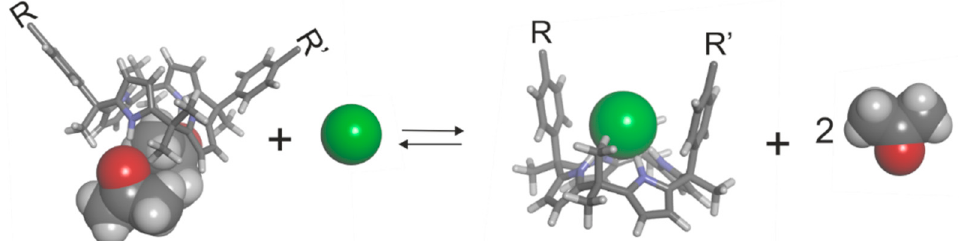
Figure 5. Molecular structures of the species involved in the 1:1 binding equilibrium used to calculate the electronic interaction energies of chloride binding to the receptors’ series: Δ E = [E(chloride_complex) + 2 × E(acetone)] − [E(acetone solvated 1,3-alternate receptor) + E(chloride)]. The receptor is displayed in stick representation. The chloride and the acetone molecules are shown as CPK models.